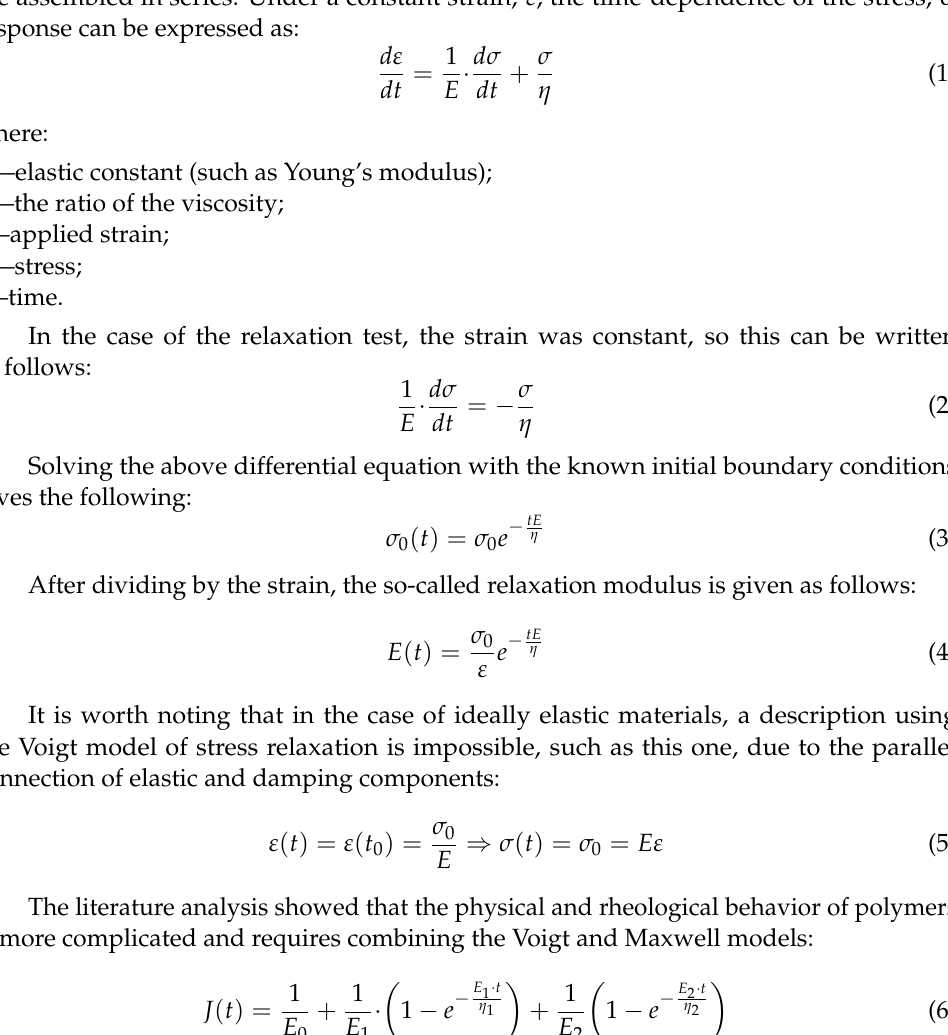
Figure 7. Stress relaxation test—force response: ( a ) mean curves for PUR80; ( b ) mean curves for PUR90.